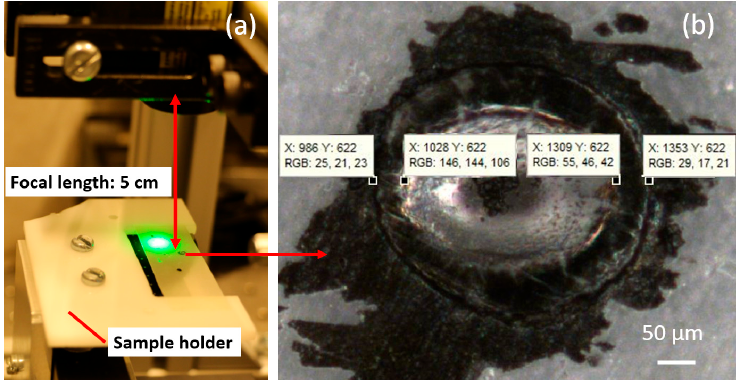
Figure 3. Laser beam diameter estimation: ( a ) the tape is mounted roughly 5 cm away from the focal lens and a reference mark is used to estimate the laser beam diameter at its maximum intensity; and ( b ) zoomed image of a laser beam burn with the inner and outer diameter in pixels. The inner and outer diameters of the laser beam burn marks are presented in micrometers, as shown in Table 1. The inner diameter represents presumably the diameter of the laser beam when its intensity is at its maximum. This estimation was done to obtain an idea of the scale of the laser beam diameters and it was used to narrow down the size of microchips used in die release tests. Table 1. Inner and outer diameters of the laser beam.